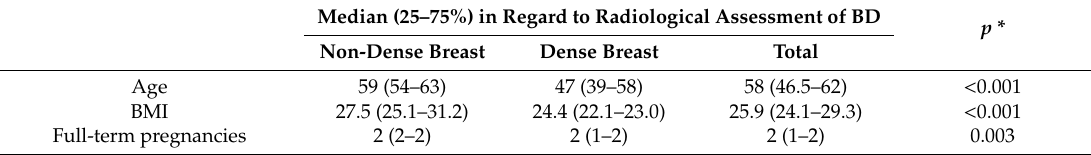
Table 3. Di ff erences in data regarding the radiological assessment of